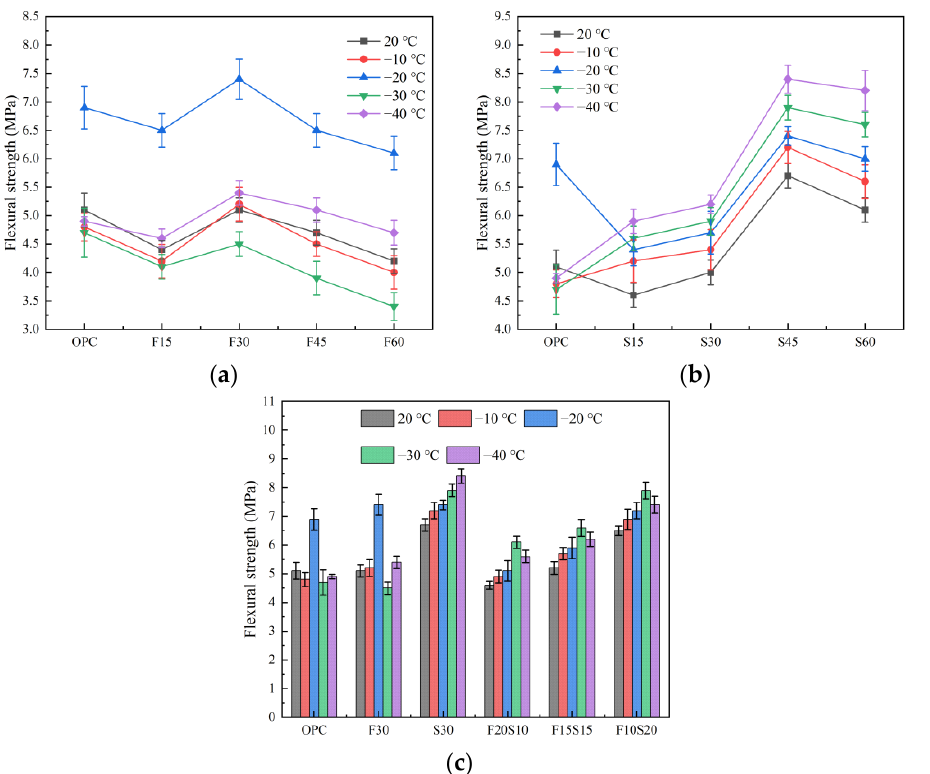
Figure 4. Flexural strength of the concrete. ( a ) Mixed with fly ash, ( b ) mixed with slag, and ( c ) mixed with fly ash and slag. with fly ash and